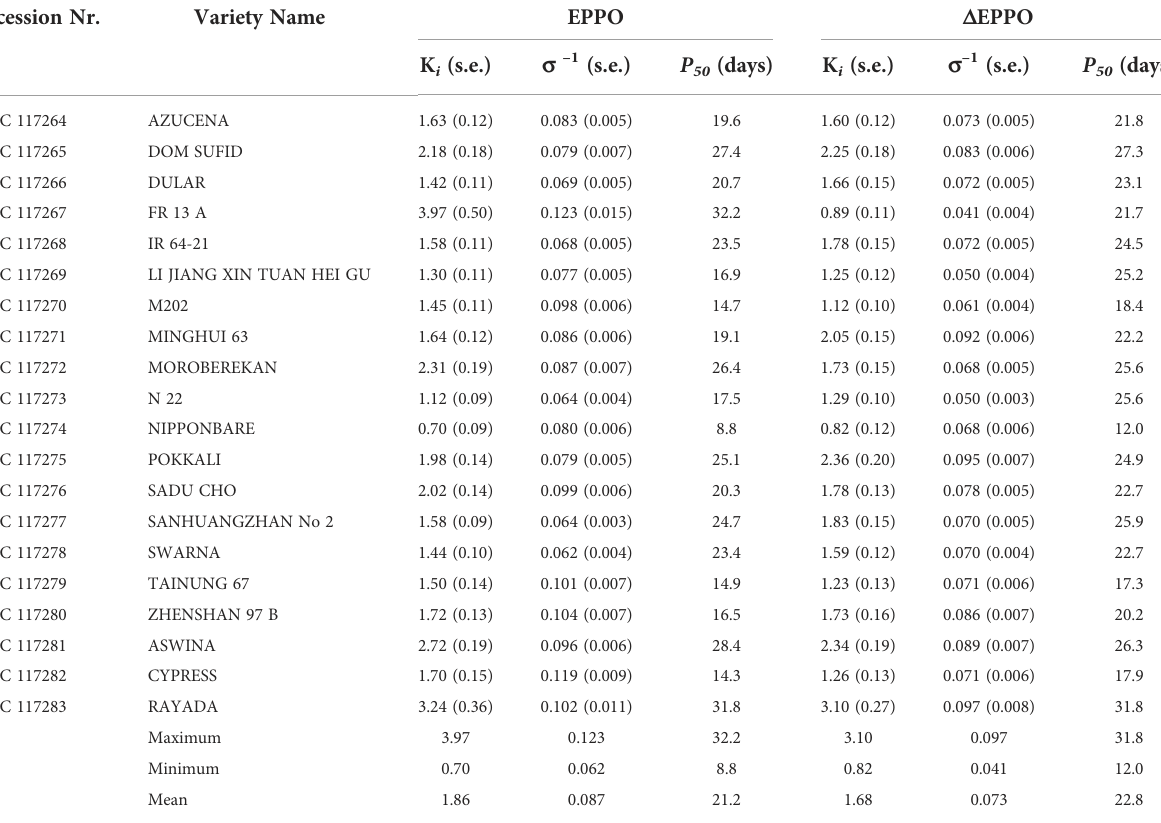
TABLE 1 Seed longevity parameters derived from probit analysis of total germination data upon removal from storage for 20 rice accessions under dry-EPPO aging conditions in experiment 1. Accession